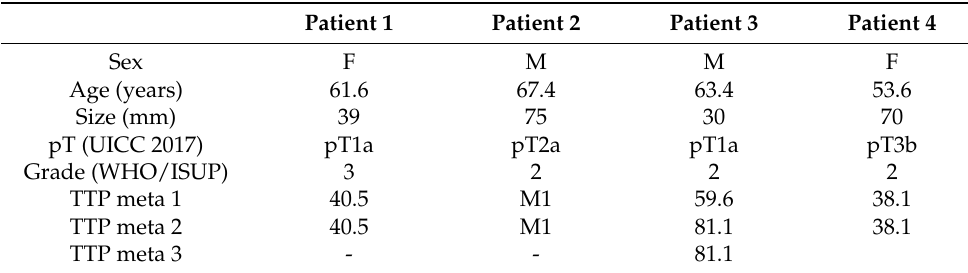
Table 1. Primary tumors: clinicopathological